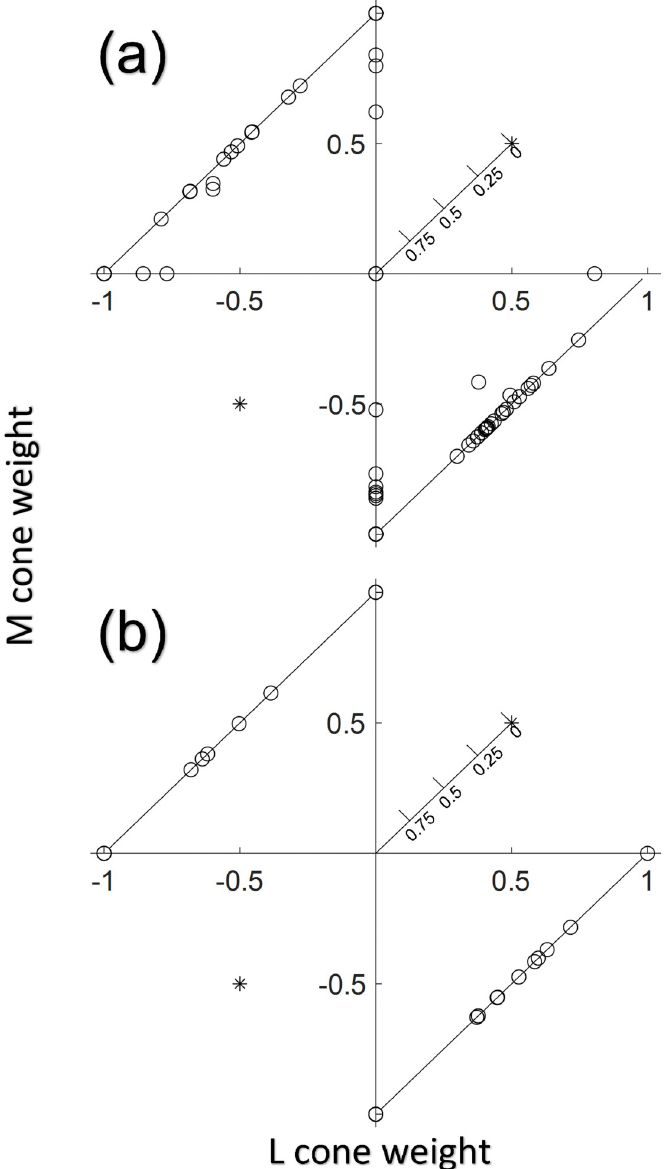
Fig 4. Cone weights of RGCs from M3. The horizontal axis shows L cone weight, the vertical axis the M cone weight, and the distance from the origin shows the S cone weight where further away from the origin corresponds to less S- cone weighting. In (a) , 100 RGCs (a superset of the cells in Fig 3C, does not contain any cells from Fig 4B) were recorded across the entire width of the GCaMP-expressing ring in M3. There were 3 cells that only showed S cone responses, represented by overlapping circles at the origin. There were also 4 L+M and 11 -L-M luminance only cells that are represented by asterisks in the upper right and lower left. Because these cells only responded to the luminance stimulus but not the L-isolating or M-isolating stimulus, the response sign is known but not the exact L or M cone weighting. In (b) , 34 cells (a superset of the cells in Fig 3D) at the innermost edge of the foveal slope in M3, served by the centermost foveal cones, were recorded from. No consistent S only responses were observed, and there were 5 L+M and 2 -L-M luminance only